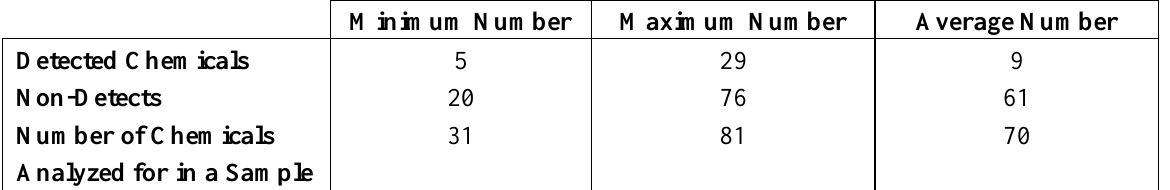
Table 3. The number of chemicals ( n ) in the final set of samples.